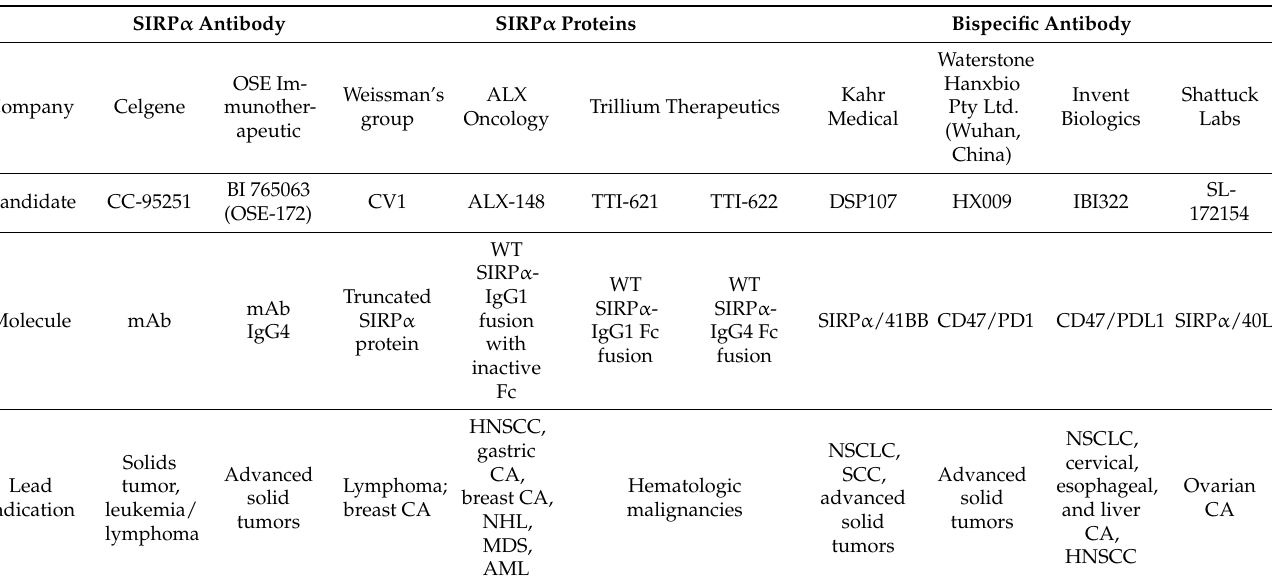
Table 2. SIRP α , SIRP α proteins, and bispecific